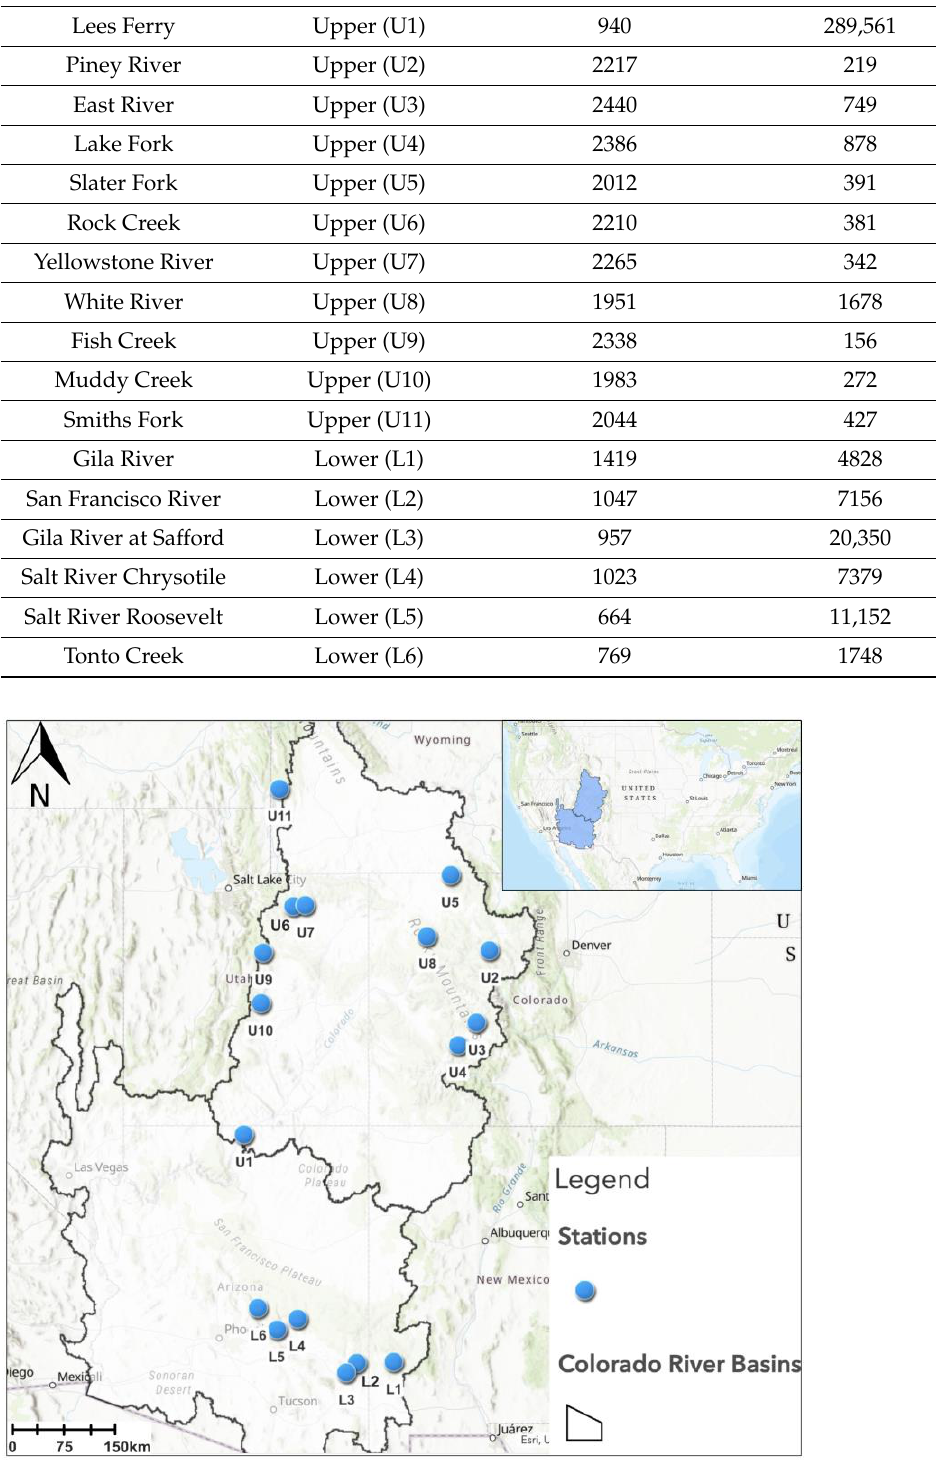
Figure 1. Map of stations used in this study for Upper and Lower Colorado River basin. Table 1. List of Stations with characteristics.